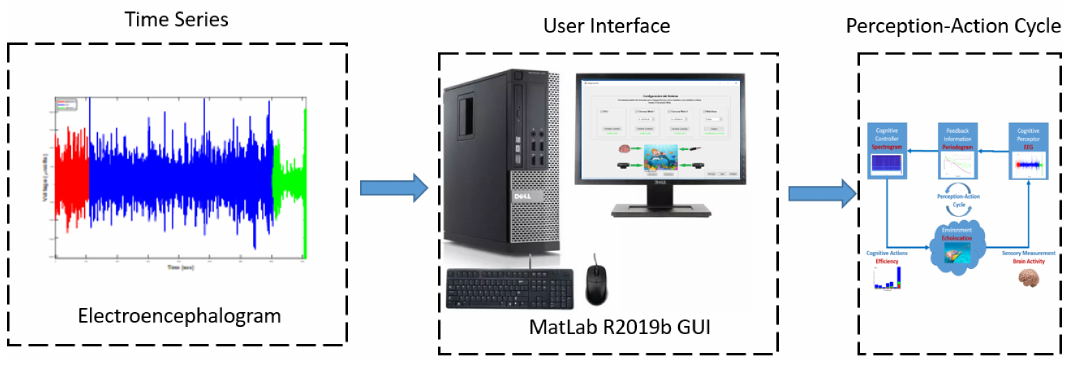
Figure 10. EEG Processing.